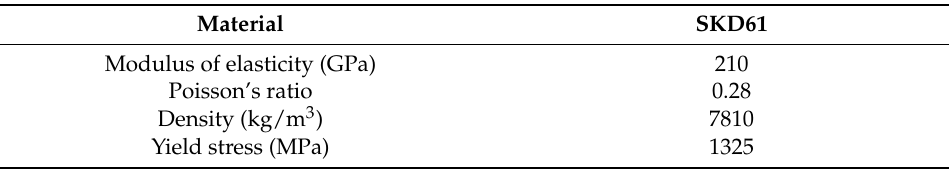
Figure 2. Finite element modeling of the extruder. Table 1. Material properties.